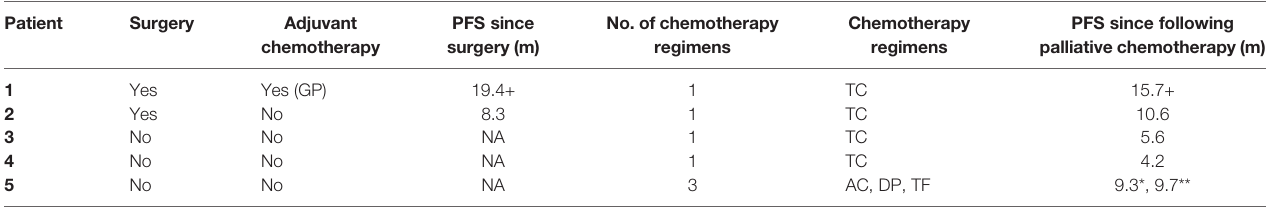
TABLE 2 | Treatment details before immune checkpoint blockade therapy.